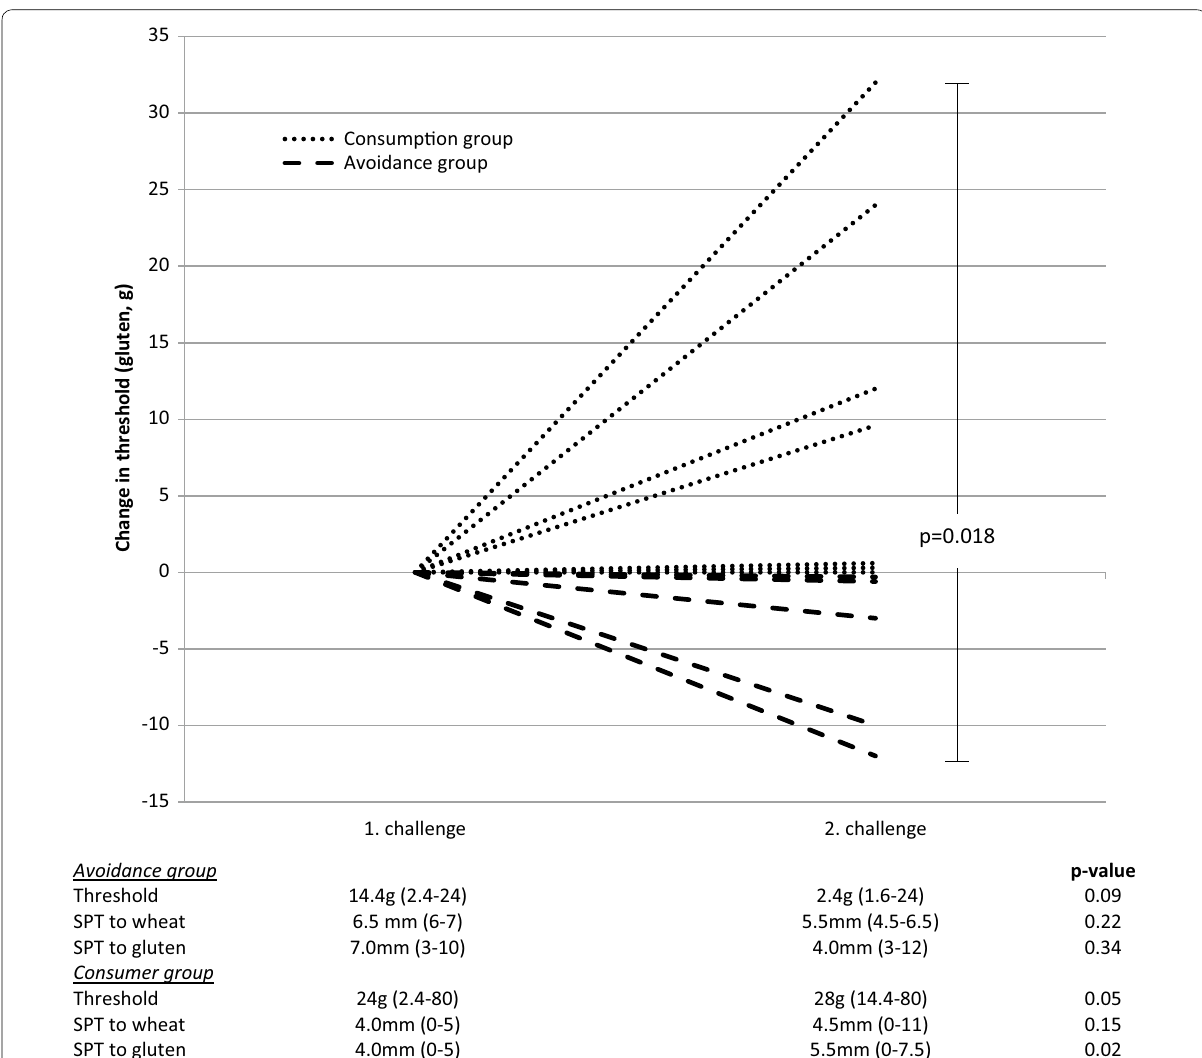
Fig. 1 Change in threshold from 1st to 2nd challenge in groups of wheat avoidance and consumption. In the wheat avoidance group (n the wheat consumption group (n 3) had an unchanged clinical threshold between the 1st and 2nd challenge. Values of threshold and SPT are = given as